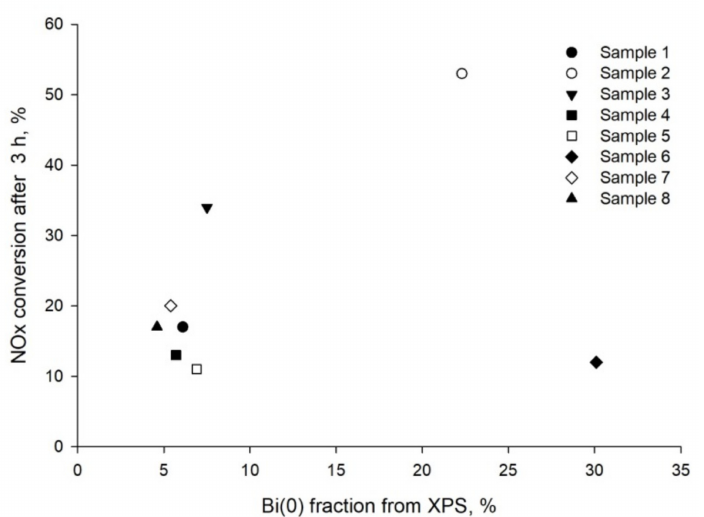
Figure 7. NOx degradation as a function of metallic bismuth on the